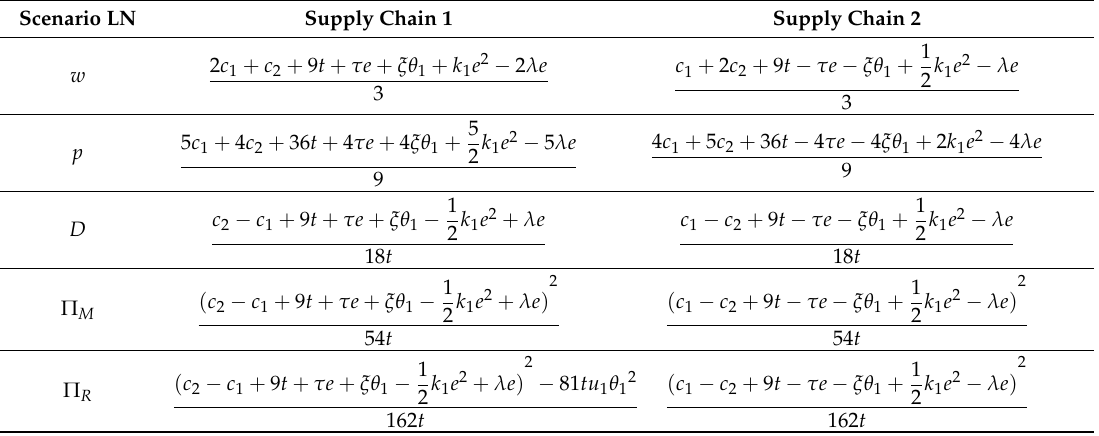
Table 4. Equilibrium outcomes with subsidy under scenario LN.